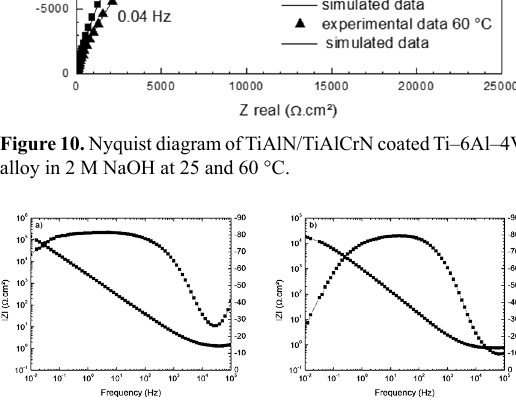
Figure 11. Bode diagrams of TiN coated Ti–6Al–4V alloy in 2 M NaOH: a) at 25, b) at 60 °C.